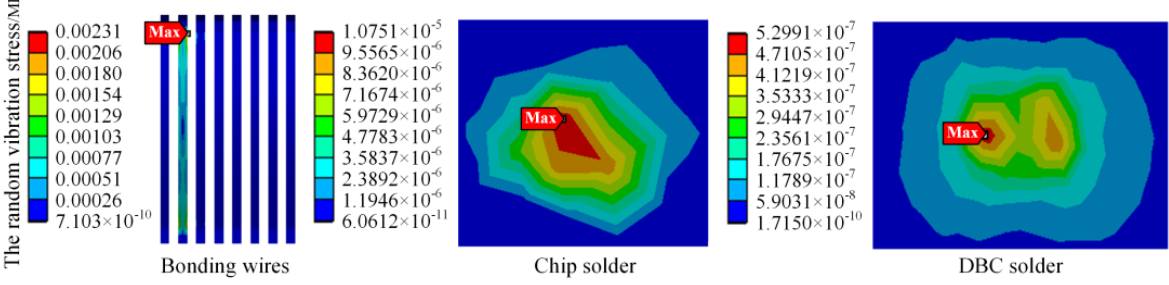
Figure 18. The random vibration stress of bonding wires, chip solder layer, and DBC solder layer.